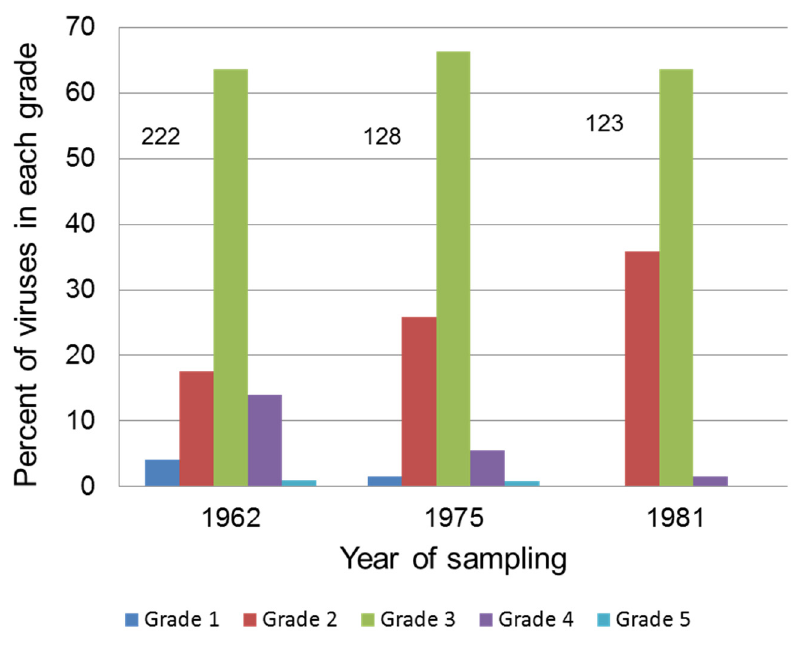
Figure 4. Virulence of Myxoma virus isolates in the United Kingdom. The proportion of MYXV isolates in each virulence grade for viruses isolated in the United Kingdom is shown. Numbers above the bars indicate the number of isolates tested. Data are from